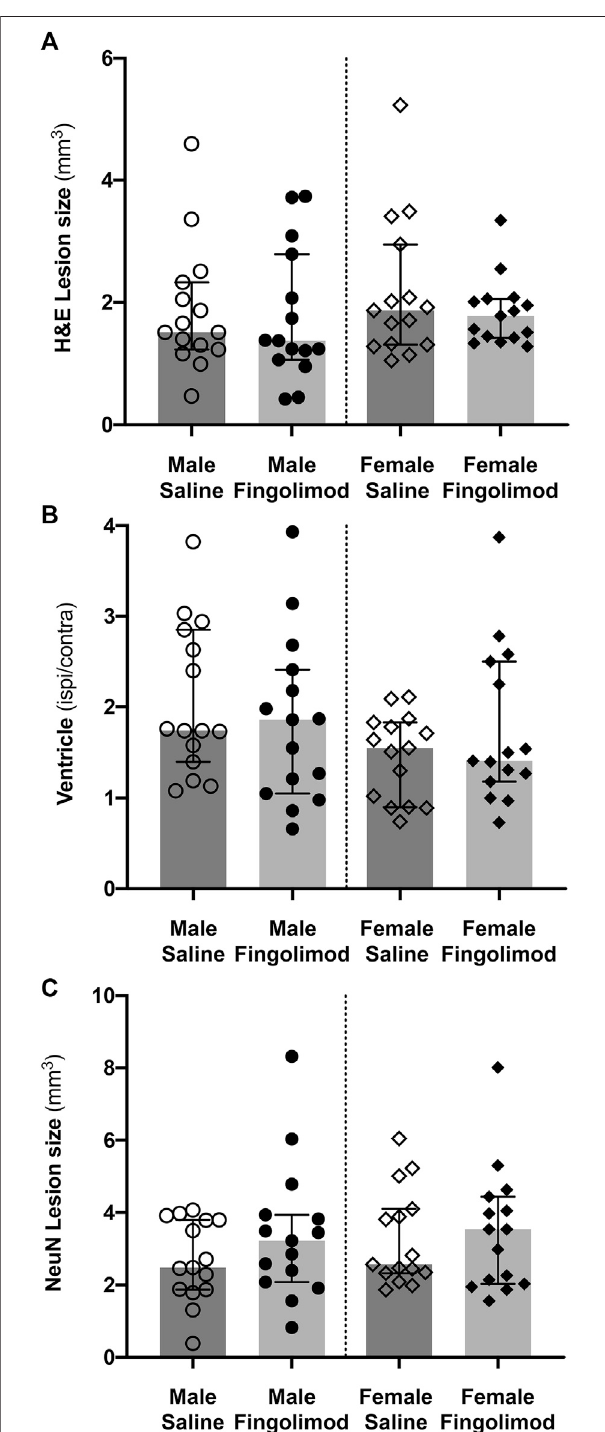
FIGURE 3 | Quanti fi cation of histological damage. Lesion size was measured on haematoxylin/eosin-stained sections (A) , and NeuN-stained sections (C) . The ratio of ipsilateral to contralateral ventricle size was measured on haematoxylin/eosin-stained sections (B) . Values are shown as median ± 95% con fi dence intervals. Fingolimod treatment had no signi fi cant effect on any of these measurements.